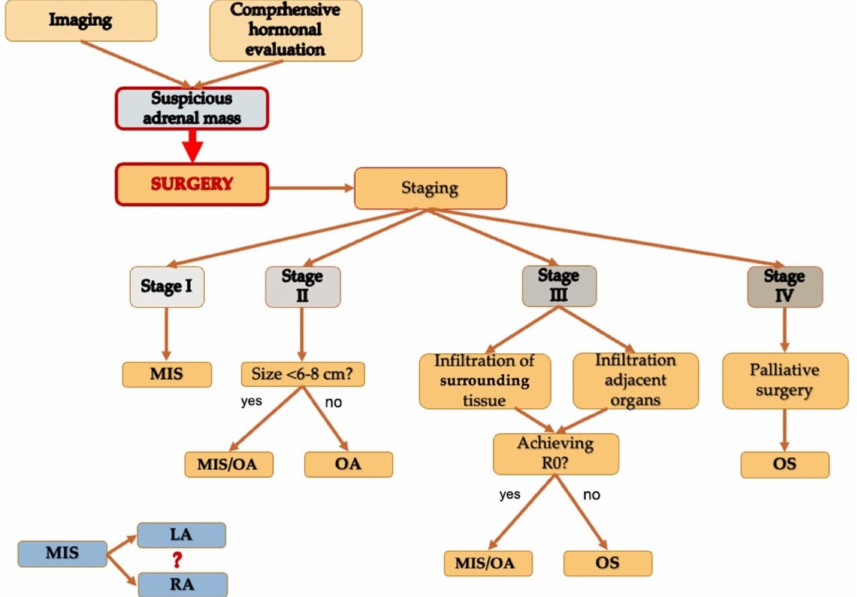
Figure 3. Conclusions: Surgical treatment and management of adrenocortical carcinoma. MIS, Minimally Invasive Surgery; OA, Open Adrenalectomy; OS, Open Surgery; LA, Laparoscopic Adrenalectomy; RA, Robotic